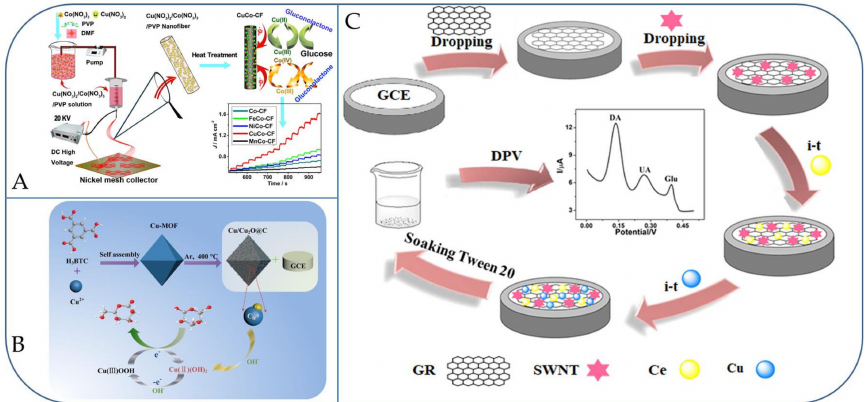
Figure 4. ( A ) Diagrams illustrating the fabrication of CuCo–CFs; ( B ) Cu/Cu 2 O@C/GCE; and ( C ) GR- SWCNT-Ce-Cu-Tween 20/GCE nanostructured electrodes for electro-chemical oxidation of glucose. Reproduced with permission from Refs.